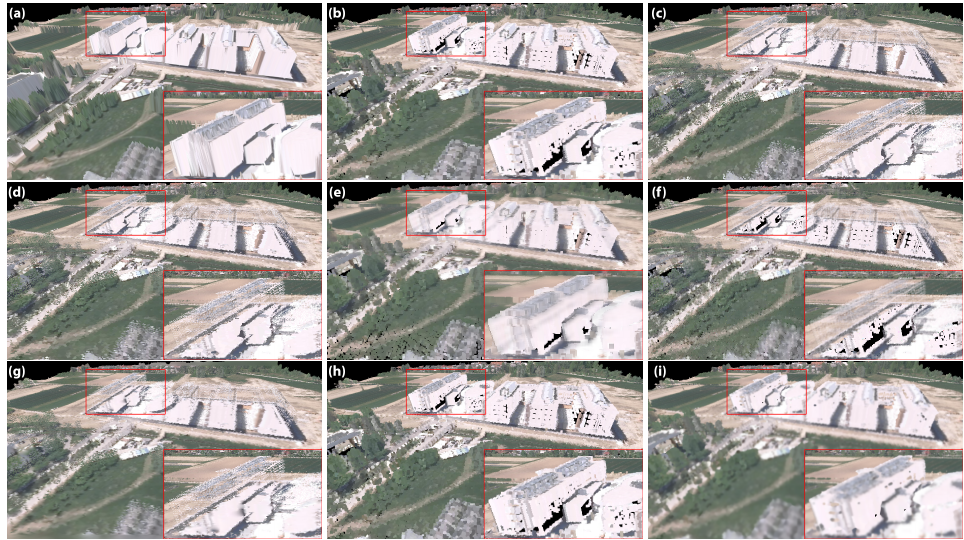
Figure 5. Rendering results for a scene with complex buildings of the presented rendering methods: ( a ) mesh; ( b ) fixed points; ( c ) nearest neighbor; ( d ) jump flooding; ( e ) inverse distance weighted; ( f ) inverse distance weighted with splats; ( g ) natural neighbor; ( h ) paraboloids, and ( i ) our